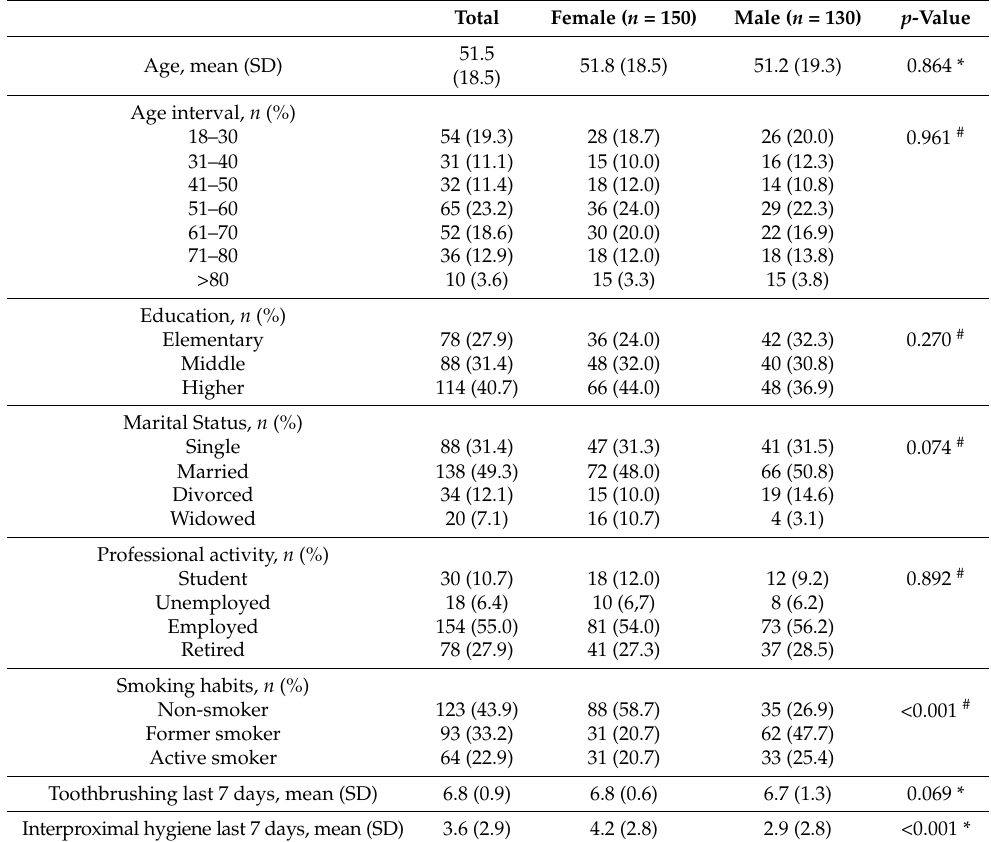
Table 3. Sociodemographic characteristics of the included participants ( n =